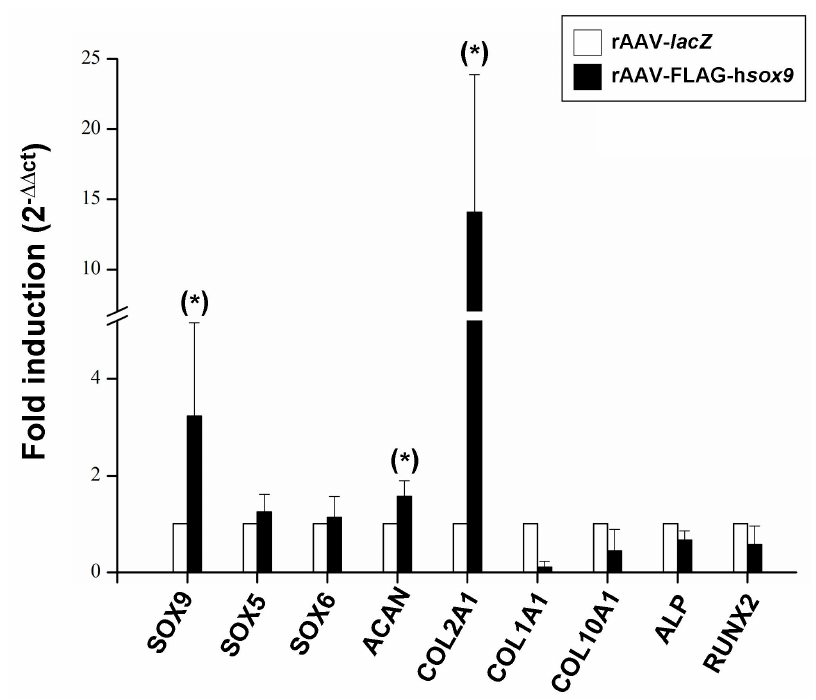
Figure 6. Real-time RT-PCR analysis in hydrodynamic cultures of rAAV-transduced hMSCs seeded in fibrin-PU scaffolds. Cells were transduced, seeded in PU scaffolds, and placed in rotating bioreactors as described in the Figures 1–5 and in Materials and Methods. After 21 days of bioreactor cultivation, mRNA was directly isolated from the constructs of rAAV-transduced hMSCs in fibrin-PU scaffolds and the gene expression profiles of SOX9, SOX5, SOX6, aggrecan (ACAN), type-II (COL2A1), type-I (COL1A1), type-X collagen (COL10A1), alkaline phosphatase (ALP), and runt-related transcription factor 2 (RUNX2) were monitored, with GAPDH serving as a housekeeping gene and internal control (all primers are listed in Materials and Methods). Ct values were obtained for each target and for GAPDH as a control for normalization, and fold inductions (relative to lacZ -treated samples) were measured by using the 2 −ΔΔ C t method. * Statistically significant compared with rAAV- lacZ .